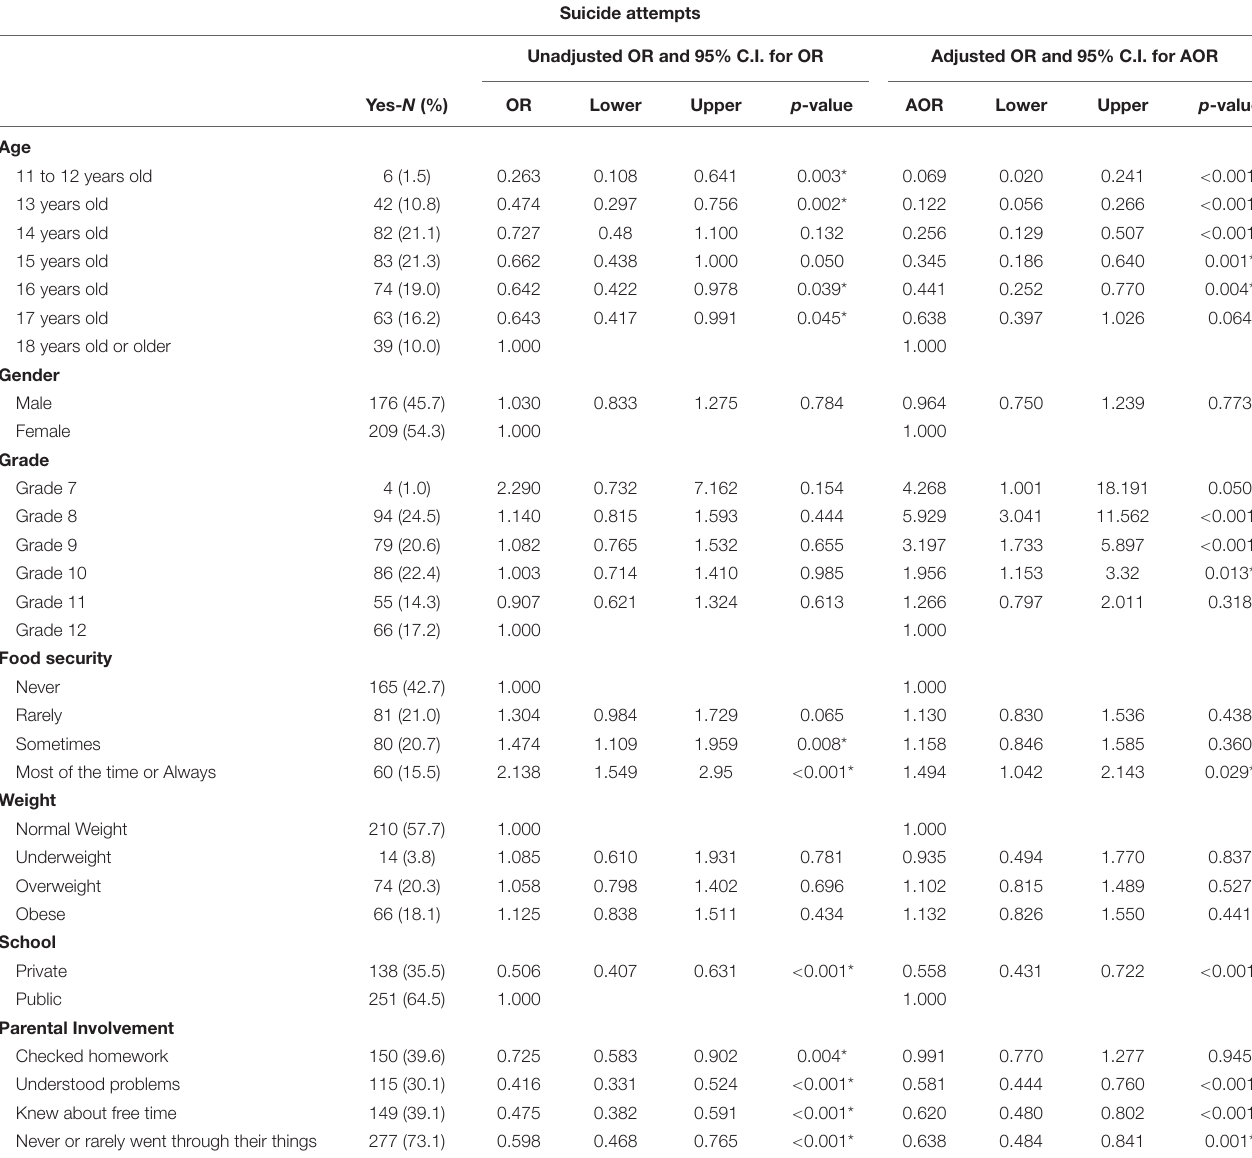
TABLE 4 | Bivariate and multivariate results of the association between attempting suicide and weight category with other demographics of participants. Suicide attempts Unadjusted OR and 95% C.I. for OR Adjusted OR and 95% C.I. for AOR Yes- N (%) OR Lower Upper p -value AOR Lower